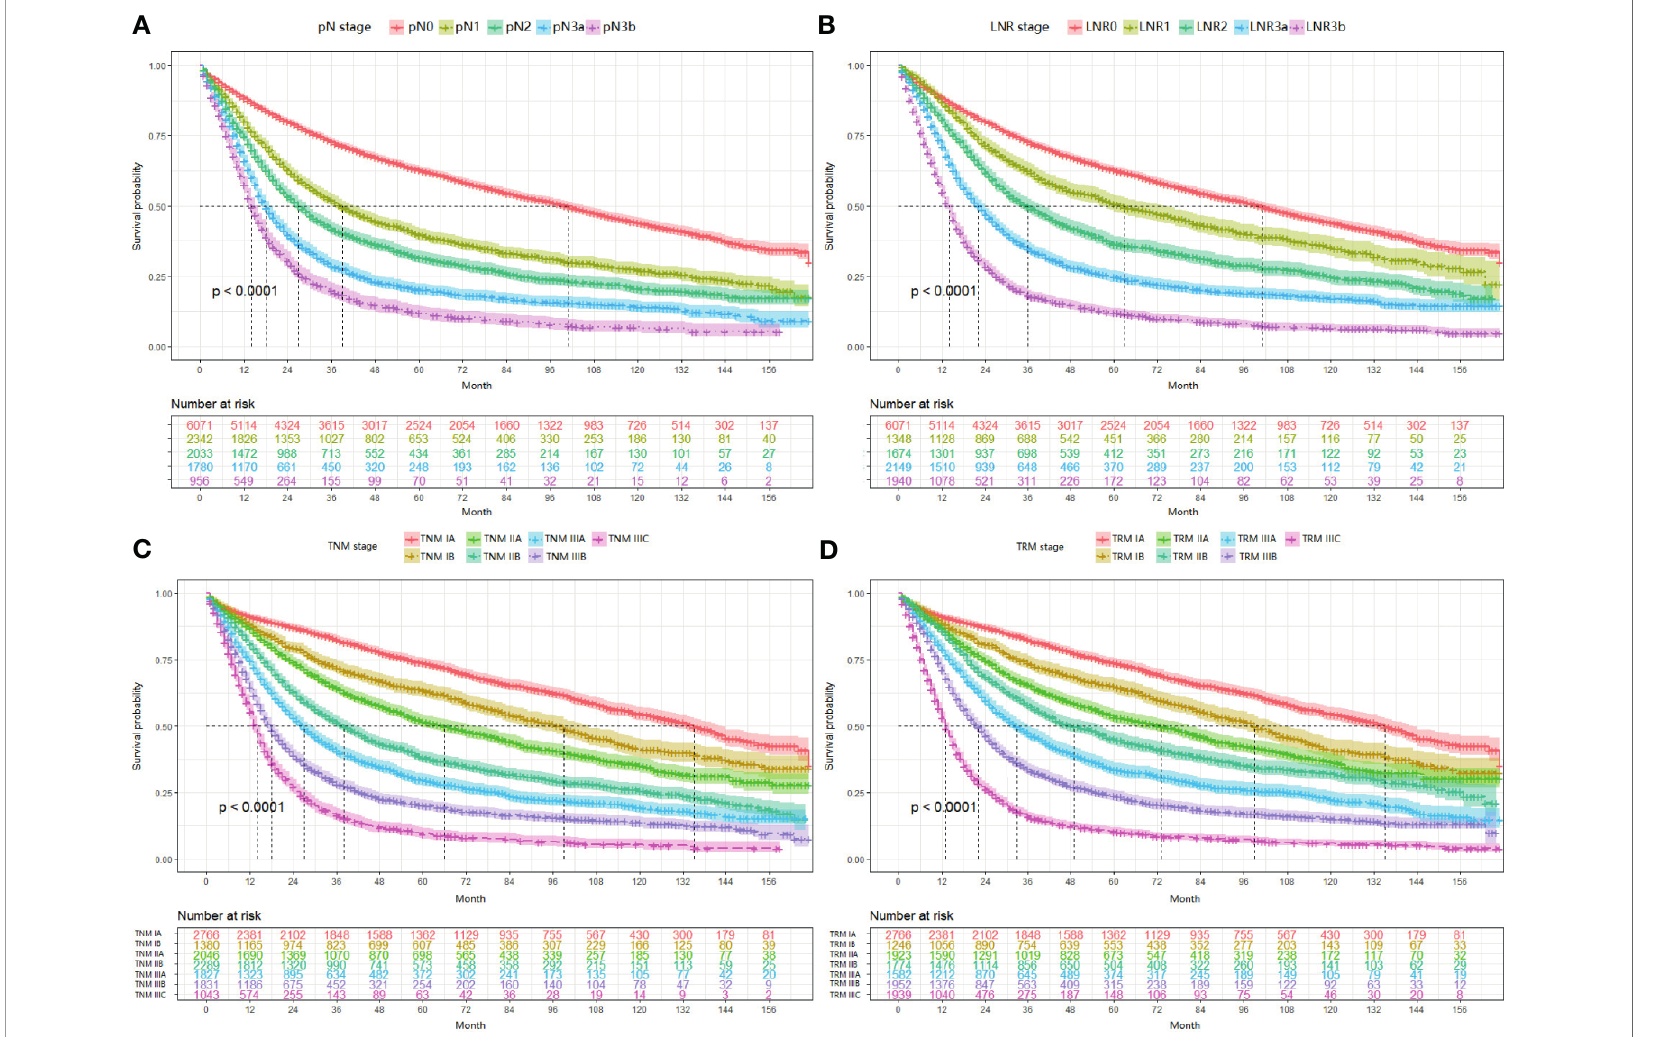
FIGURE 2 | Impact of the pN (A) , LNR (B) , TNM (C) , and TRM (D) staging on OS in validation set. (A) pN stage: pN0 vs pN1, p < 0.001; pN1 vs pN2, p < 0.001; pN2 vs pN3a, p < 0.001; pN3a vs pN3b, p < 0.001; (B) LNR stage: LNR0 vs LNR1, p < 0.001; LNR1 vs LNR2, p < 0.001; LNR2 vs LNR3a, p < 0.001; LNR3a vs LNR3b, p < 0.001; (C) TNM staging system: IA vs IB, p < 0.001; IB vs IIA, p < 0.001; IIA vs IIB, p < 0.001; IIB vs IIIA, p < 0.001; IIIA vs IIIB, p < 0.001; IIIB vs IIIC, p < 0.001; (D) TRM staging system: IA vs IB, p < 0.001; IB vs IIA, p < 0.001; IIA vs IIB, p < 0.001; IIB vs IIIA, p < 0.001; IIIA vs IIIB, p < 0.001; IIIB vs IIIC, p < 0.001. LNR, lymph node ratio; TNM, tumor – node – metastasis; TRM, tumor – ratio –